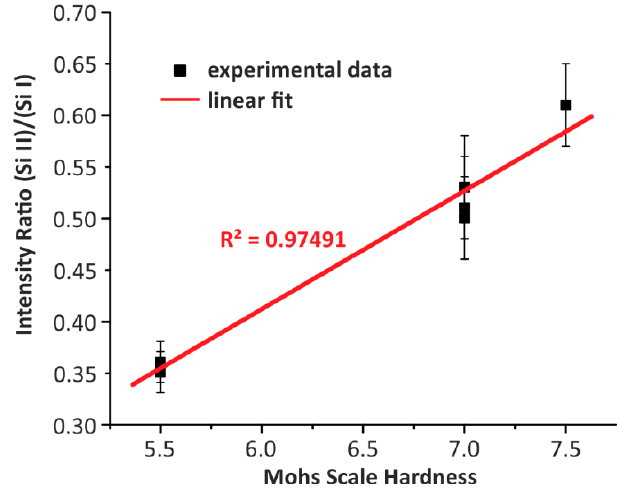
Figure 8. Silicon ionic to atomic ratio vs. Mohs’s hardness of gemstone samples.